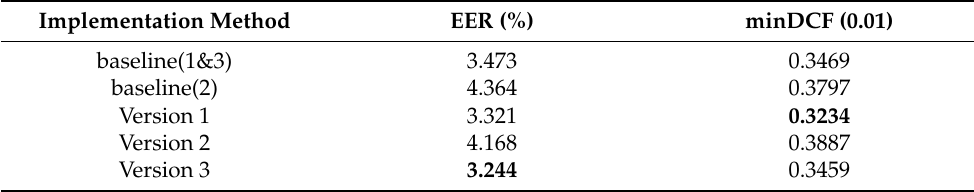
Table 3. Results of different PPL loss implementation methods on VoxCeleb. (AM-Softmax + λ PPL λ = 0.1, C = 32).